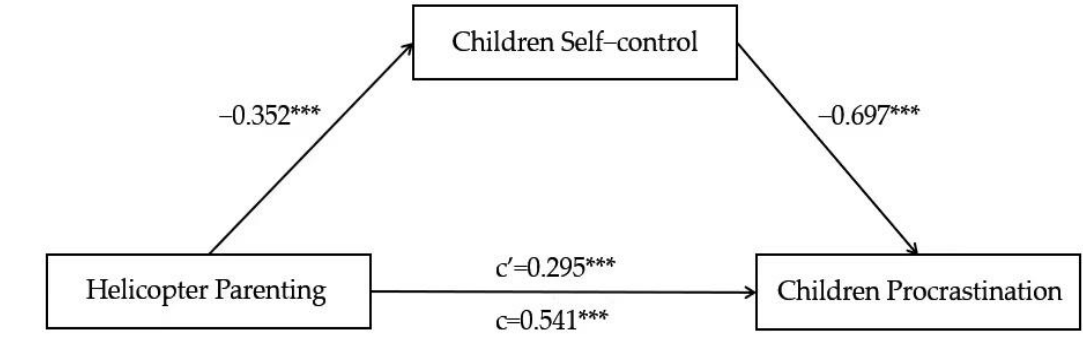
Figure 4. Mediating effects of children’s self-control on the relationship between helicopter parenting and children’s procrastination. C: B = 0.541, SE = 0.052, CL = [0.436, 0.463]; C’: B = 0.295, SE = 0.046, CL = [0.205, 0.385].